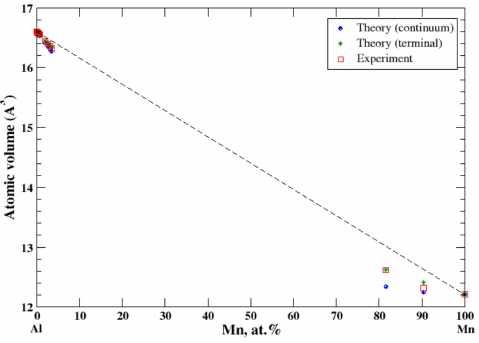
Figure 4. Atomic volume vs. concentration for Al-Mn alloy system. The experimental data are from Ref. [16] (pp.